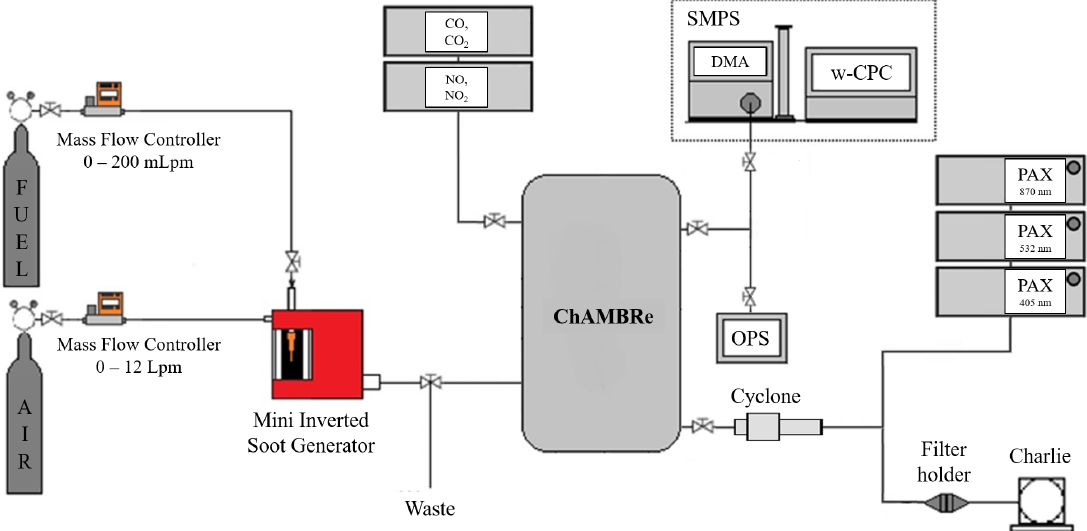
Figure 2. Layout of the MISG set-up at